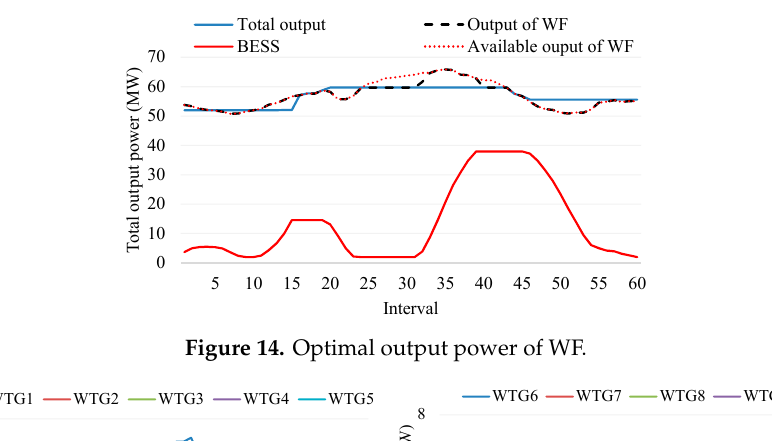
Figure 12. Optimal output power of WF. ( a ) ( b ) Figure 13. Optimal set-points of WTGs in WF: ( a ) Cluster 1; ( b ) Cluster 2. 6.6.2. Case study 2: Ratio ( β / α ) is 0.5/0.5 and BESS size is 40 MW Similar to the previous section, a two-stage optimization is used to determine the optimal output power of the WF system and the optimal set-points of WTGs. The use of BESS enables the WF system to generate more output power and also reducing the fluctuations in output power from the WF system compared to the first case study. The purpose of BESS is to shift power from peak output intervals to off-peak output intervals to reduce fluctuations in output power from the WF system. It can be observed from Figure 14 that the output power of the WF system increases significantly when using BESS. This output power of the WF system is almost equal to the maximum output power from